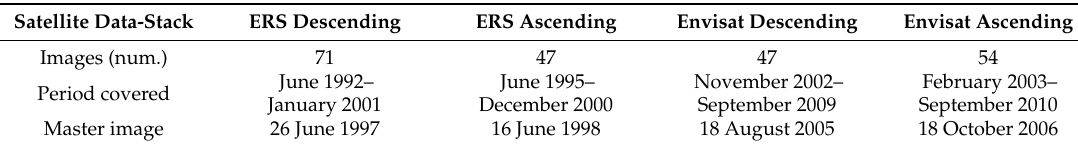
Table 1. Archived data stacks selected for the A-DInSAR analyses. Satellite Data-Stack ERS Descending ERS Ascending Envisat Descending Envisat Ascending Images